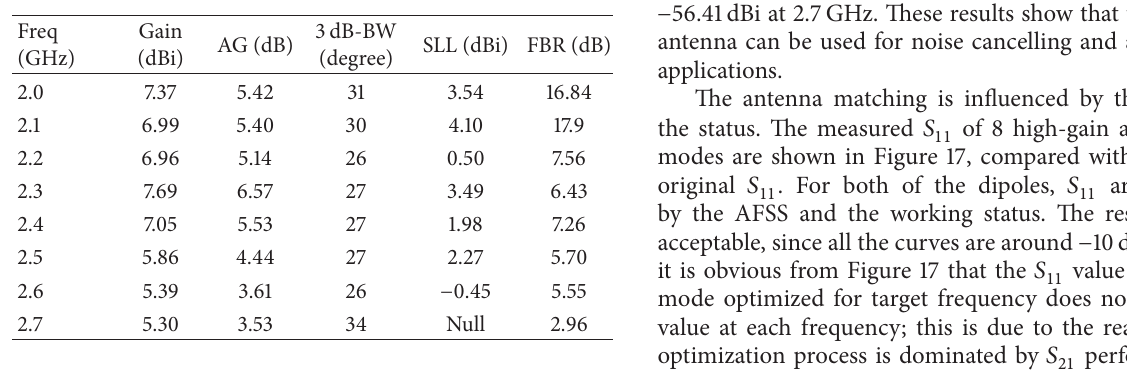
Table 1: Survey of the high-gain